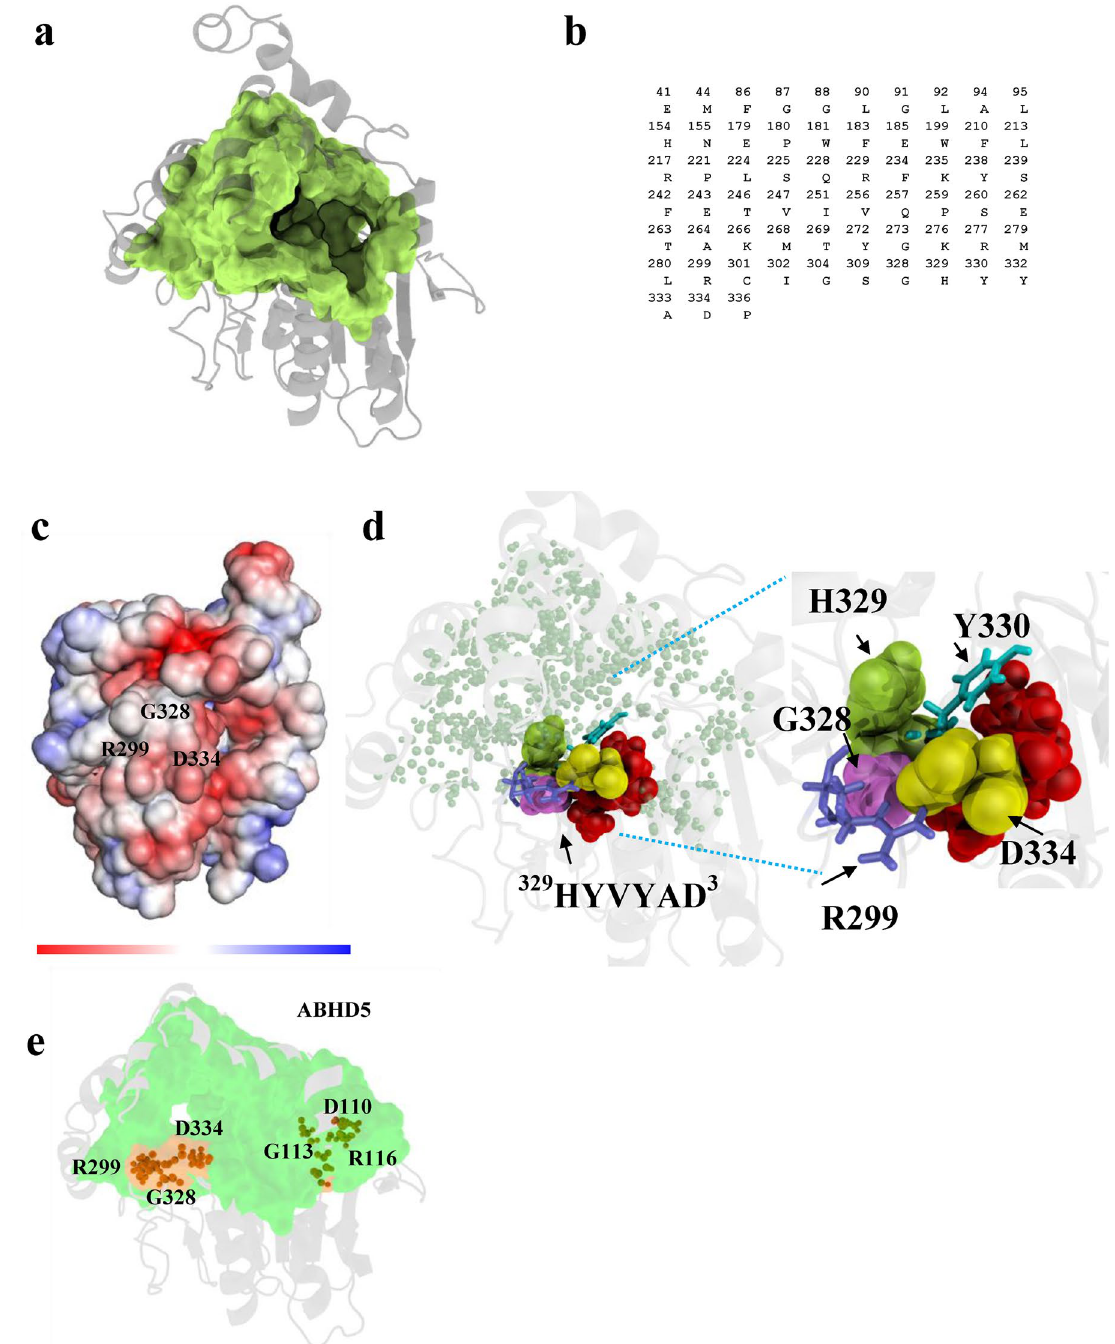
Figure 3. Shape analysis on ABHD5 surface. ( a ) Using the 3D weighted alpha shape with the flow algorithm, shape analysis was performed on the ABHD5 refined structural model. The binding pocket of ABHD5 was identified and assessed for the geometric measurement of molecule volume, solvent accessible area and the number of pocket residues in ( b ). The spatial pattern of the ABHD5 binding pocket represents a novel binding surface in ABHD family. The binding pocket possesses the key residues R299, G328 and D334 that play a crucial role in activating ATGL lipolysis. ( c ) The biochemical and biophysical properties of the binding pocket reflects on the computed electrostatic potential surface. The color key ranges from − 5 kT/e (red) to 5 kT/e (blue). The neighborhood of R299, G328 and D334 exhibits a stronger negatively charged surface that is a hotspot or interface of interacting with positively charged binding partners. ( d ) As the geometric center of R229GD surface patch, D334 is clustered spatially with R299, G328 (pink), H329 (green), Y330 (cyan) and V 331 Y 332 A 333 (red) buried on the binding pocket (light green dots). The close up view showed the geometric orientation of the surface patch R 299 G 328 D 334 while positively charged D334 (yellow spheres) is stabilized with negatively charged R299 (blue sticks) with a salt-bridge. ( e ) The functionally important residues (R299, G328 and D334) and (R116, G113 and D110) are identified and characterized on the binding surfaces of